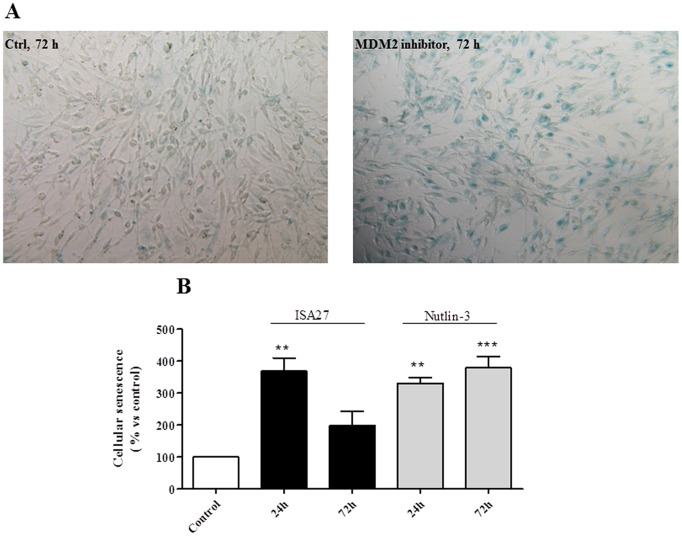
ISA27 induces U87MG cell senescence.
8A) Representative images of SA-β-Gal-expressing cells: The panel shows the SA-β-Gal-expressing MDM2 inhibitor-treated and untreated cells at 72 h. 8B) Percentage of SA-β-Gal-expressing cells: The number of SA-β-Gal-expressing cells was determined with respect to the total cells in each sample (untreated cells, ISA27- and Nutlin-3-treated cells). The percentage of SA-β-Gal-expressing MDM2 inhibitor-treated cells was then calculated with respect to the untreated cells, for which an arbitrary value of 100% was assigned.